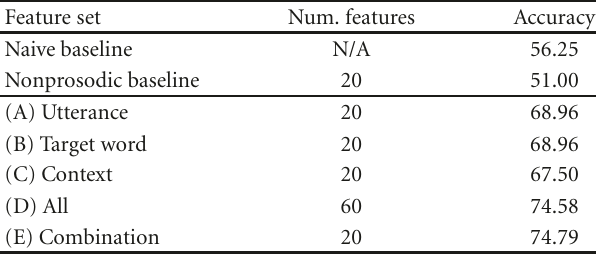
Table 6: Average classification accuracies for the linear regression models trained on five subsets of prosodic features. The model trained on the combination feature set performs significantly better than the utterance, target word, and context feature sets.